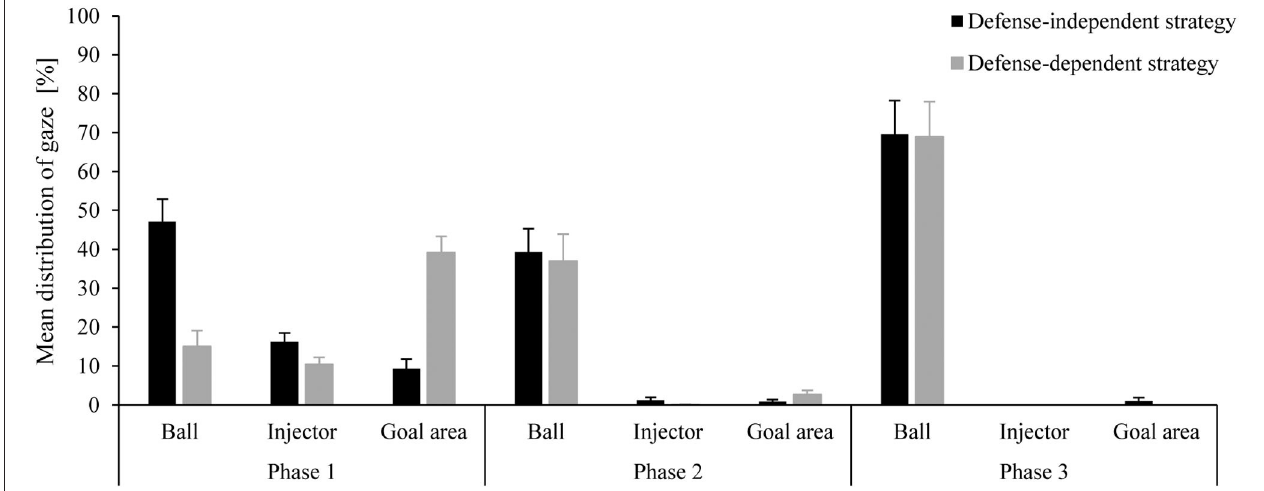
FIGURE 5 | Mean distribution (and SD) of gaze durations at the areas of interest (ball, injector, goal area) for both conditions (defense-independent; defense-dependent) as a function of time (Phase 1, Phase 2; Phase 3) and in relation to the length of a phase.